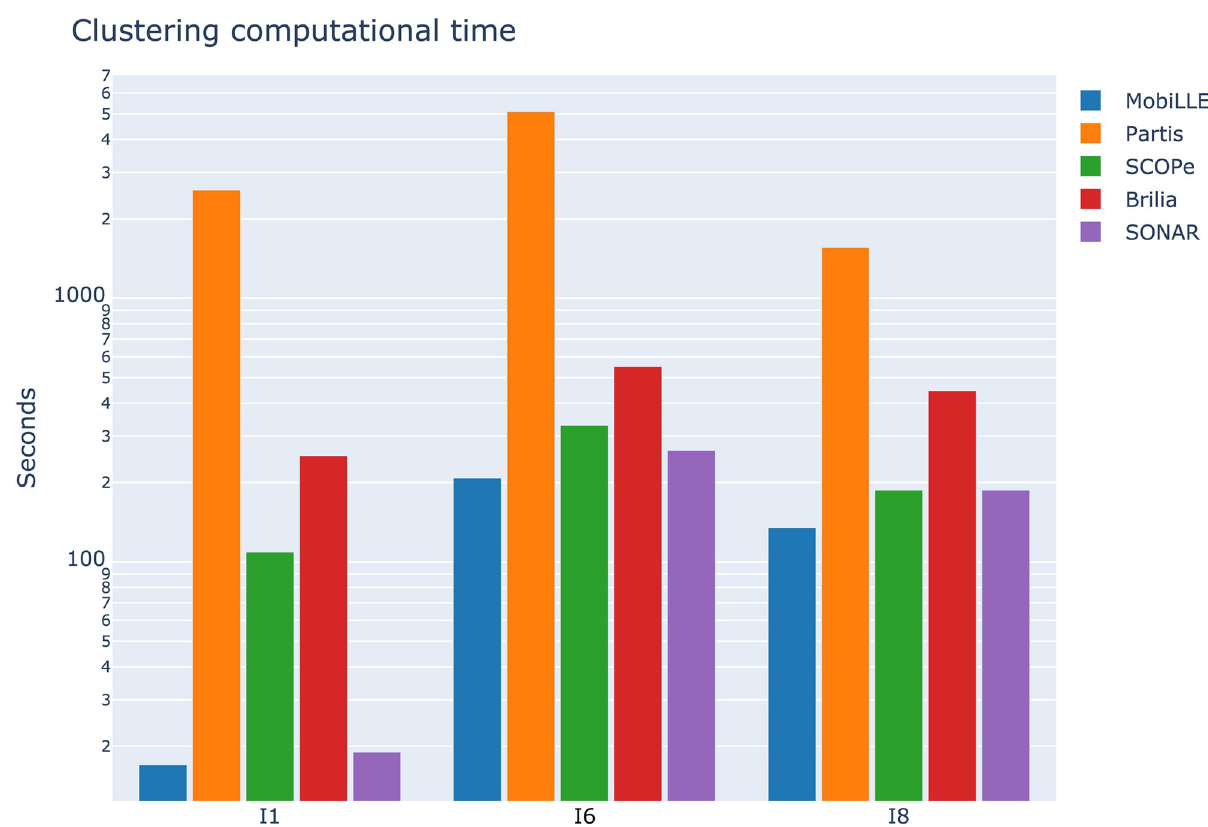
Fig 10. Comparing running times of clonal grouping tools. The running times for MobiLLe and other tools were measured for three experimental repertoires with different clonal compositions. To a better visualisation, we used log scale, S16 Table shows the time in second for each considered tool.